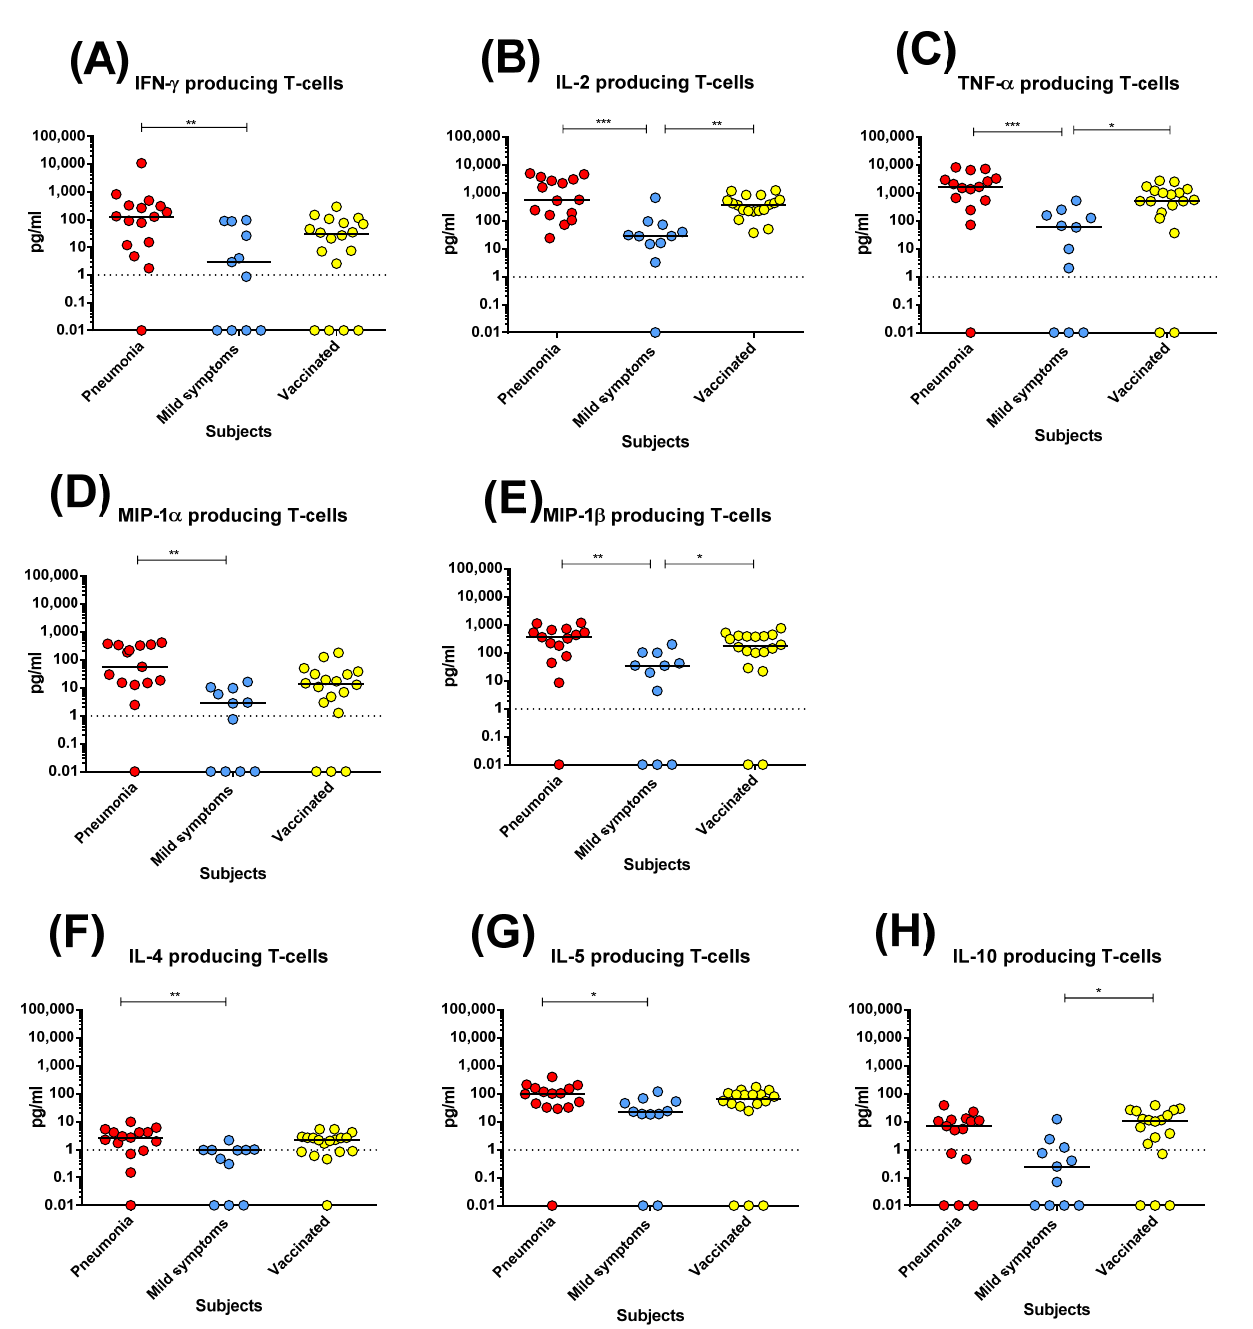
Figure 3. Cytokine production of T cells after stimulation with spike (S) peptide pools in post- COVID-19 patients with pneumonia or mild symptoms and vaccinated subjects at early time points: ( A ) IFN- γ ; ( B ) IL-2; ( C ) TNF- α ; ( D ) MIP-1 α ; ( E ) MIP-1 β ; ( F ) IL-4; ( G ) IL-5; ( H ) IL-10. Early time point: post-COVID-19 patients with pneumonia, median 59 (range 45–90) days after infection; patients with mild symptoms, 48 (24–90) days after infection; vaccinated subjects three weeks after two vaccine doses. * p < 0.05; ** p < 0.01; *** p <